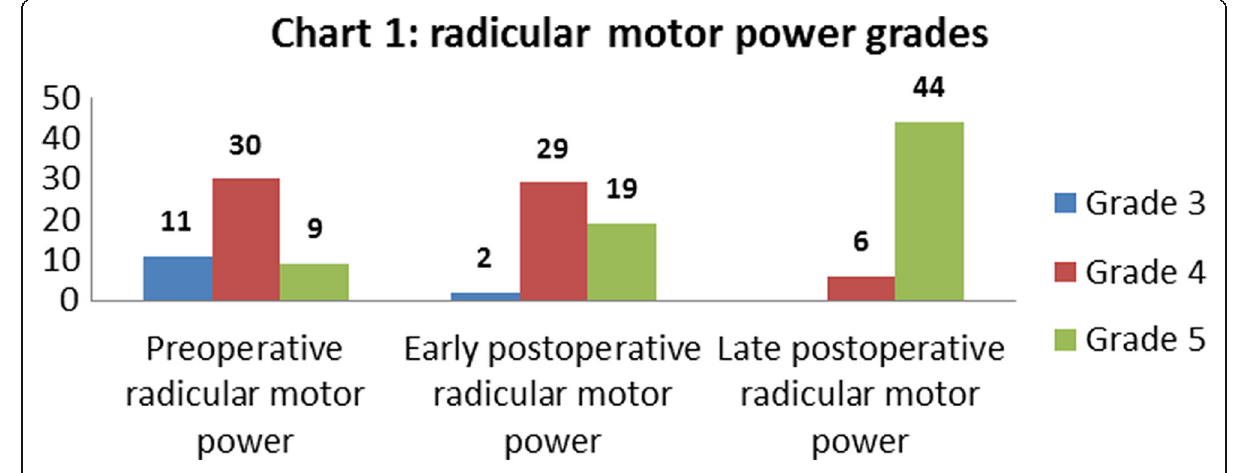
Fig. 3 A chart illustrating different values of radicular motor power